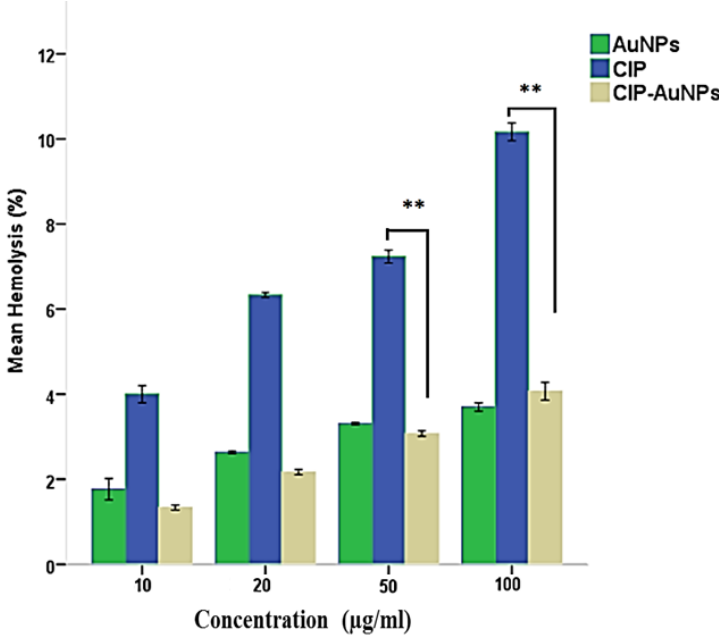
Figure 8. Hemolytic activity of CIP, AuNPs, and CIP-AuNPs, ** presents p ≤ 0.01.